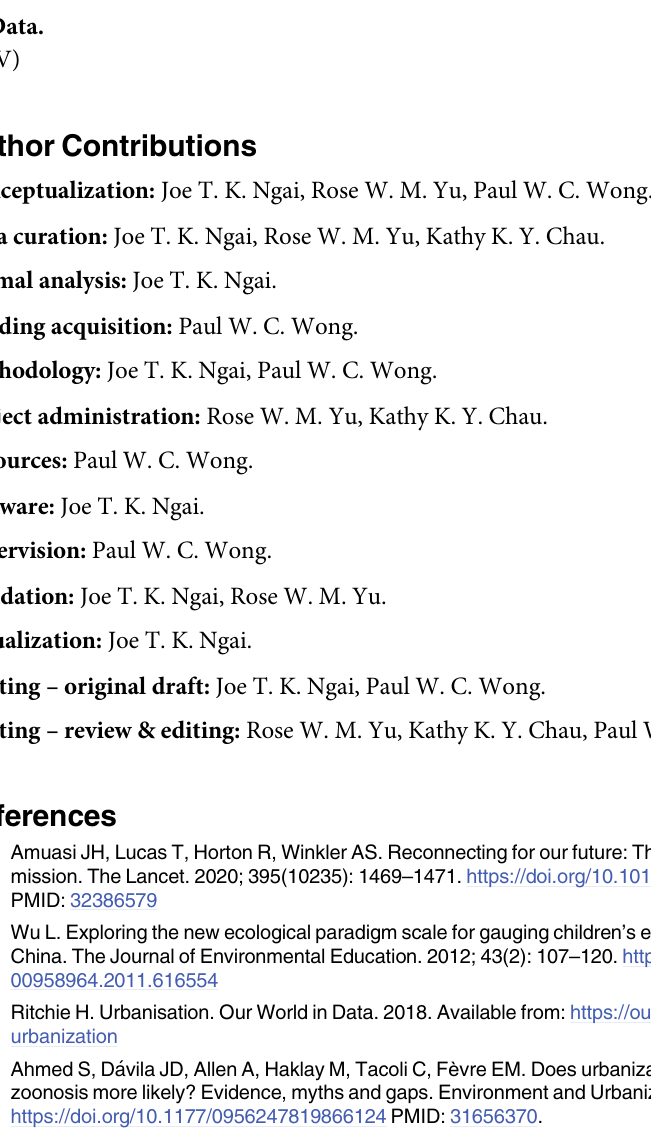
S1 Table. Summary of the CARing Kids